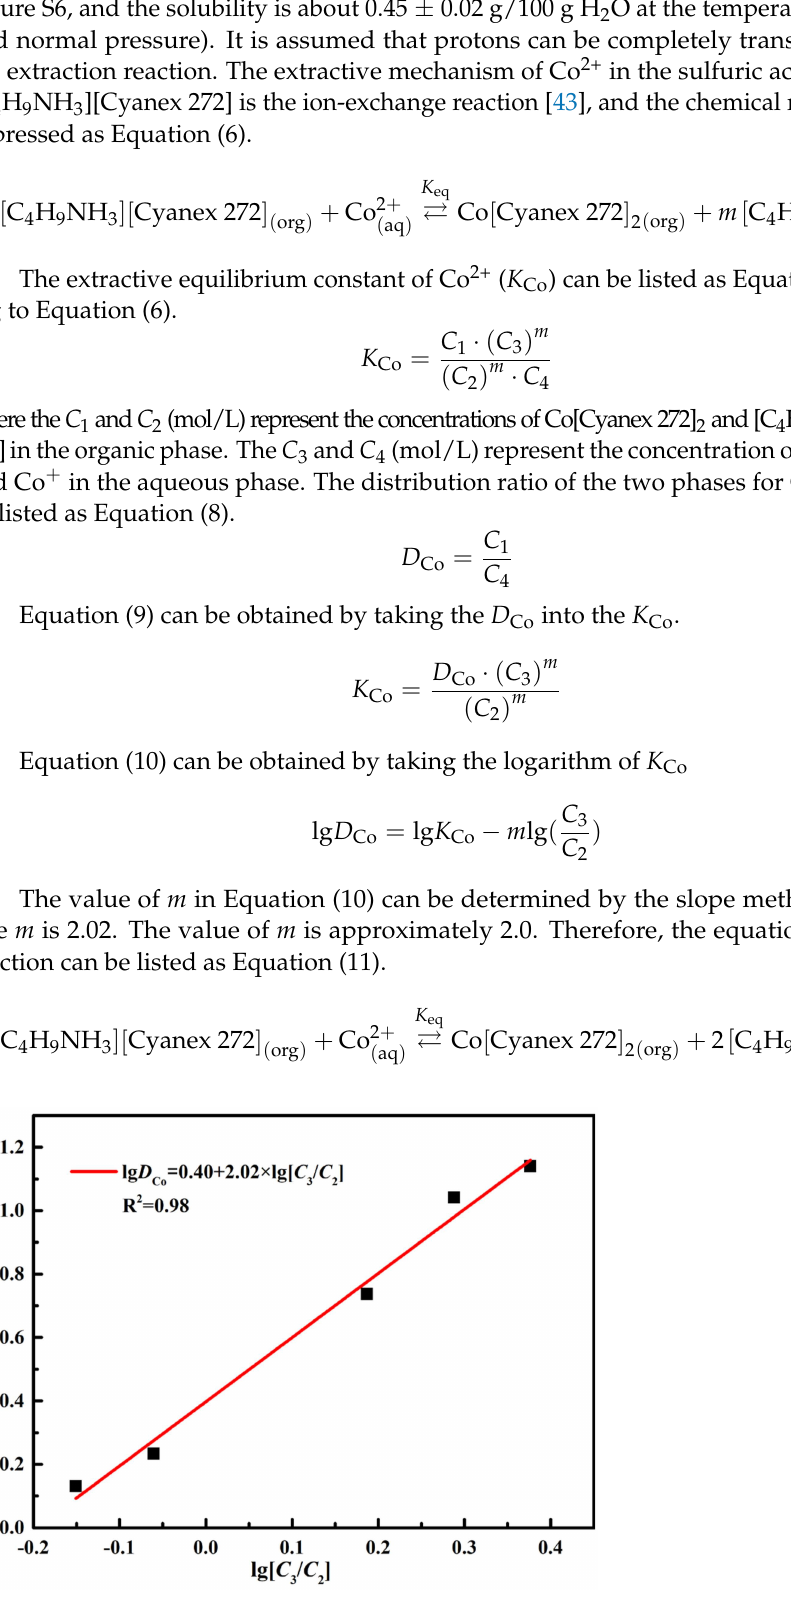
Figure 6. Slope method for the extractive